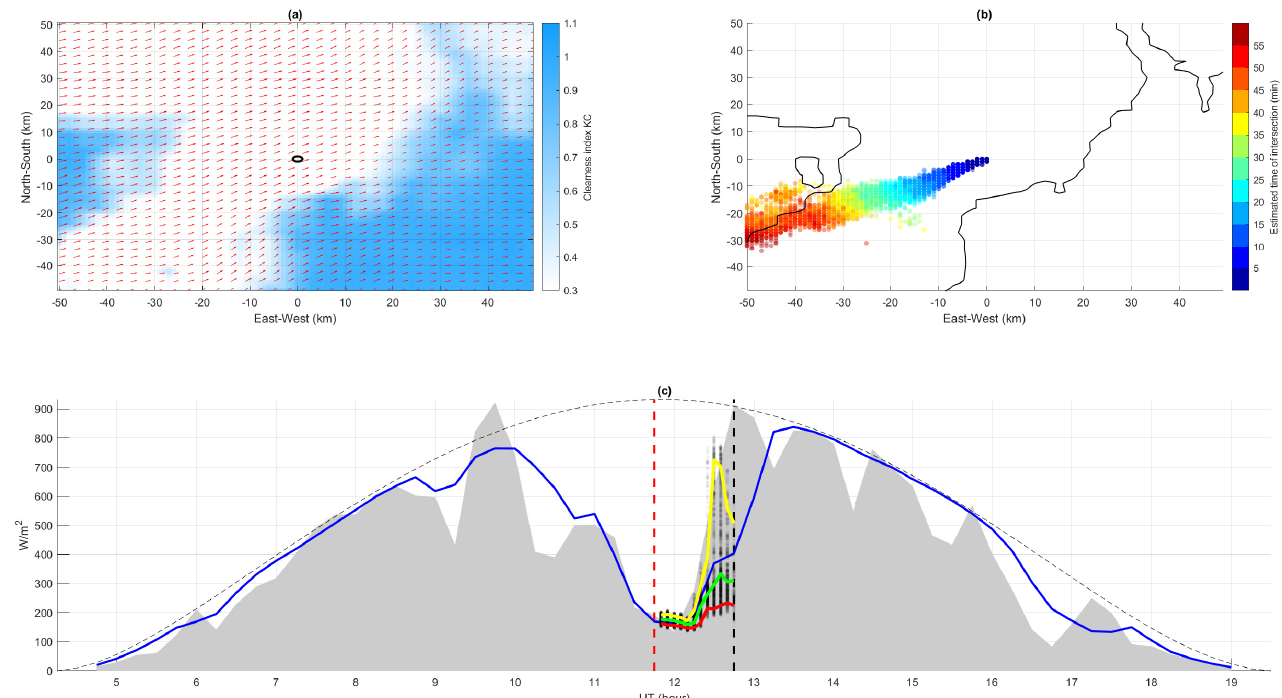
Figure 1. Example of the CMV-based probabilistic forecast on Carpentras, 11 July 2016 at 12;00 UT, for 1-h ahead every 5 min. ( a ) Clear-sky index map at 12:00 UT, along with CMV (small red arrows), with a radius of 50 km around the location of interest. ( b ) Contour map of the clear-sky index map with 0.5 as a threshold, along with dots identifying pixels converging to the monitored perimeter of interest. The color of the dots represents the estimated time of intersection. ( c ) The gray area represents the reference measured GHI at 15-min time step. The blue line represents the corresponding estimation from satellite. The black-dash line represents the corresponding clear-sky GHI. The probabilistic forecasting issued at 12:00 UT (vertical red dash line) up to 2-h ahead (vertical black dash line) is represented by the ensemble of potential converging clear-sky index k c in black dots. For illustration purposes, the 10th, 50th, and 90th percentiles of this ensemble are represented, respectively, by the red, green, and yellow